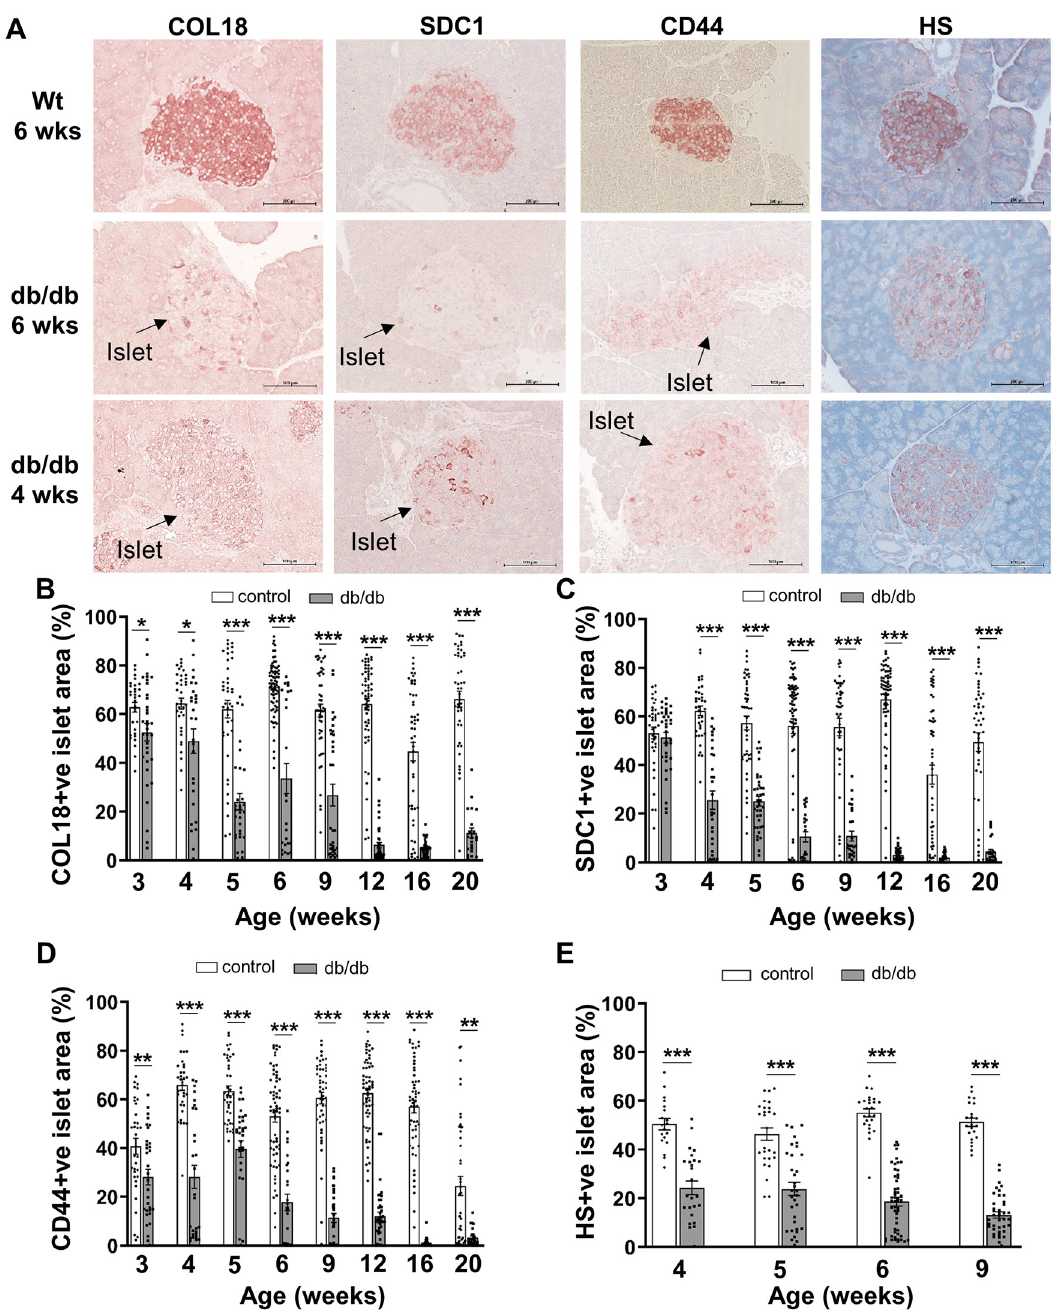
Fig 1. HSPG core proteins and HS rapidly decline in the pancreatic islets of db/db mice. ( A ) Representative images show the distribution of HSPG core proteins and HS in the islets of male db/db mice and wt mice at 4 and/or 6 weeks of age as demonstrated by immunohistochemical staining. ( B-E ) Bar graphs for each time point show morphometric analysis of the % islet stained for the HSPG core proteins ( B ) COL18, ( C ) SDC1, ( D ) CD44 and HS ( E ) in pancreases of lean control male mice (wt, db/+; open bars) and db/db mice (shaded bars). Data show mean ± SEM for 3–6 pancreases/age group with n = 21–72 islets examined/group for HSPG core proteins and n = 19–52 islets/group for HS. � p < 0.05, �� p < 0.01 and ��� p < 0.0001, Mann-Whitney test (HSPGs) and Unpaired t test (HS). Scale bar = 100 μ